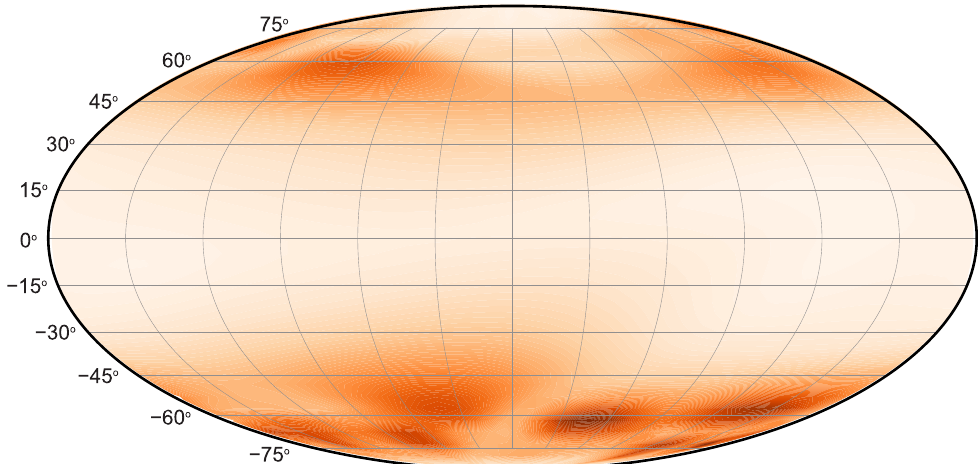
Figure 7. Recovered near-surface magnetic image of Mercury (redrawing of Figure 6a in the Moll- weide